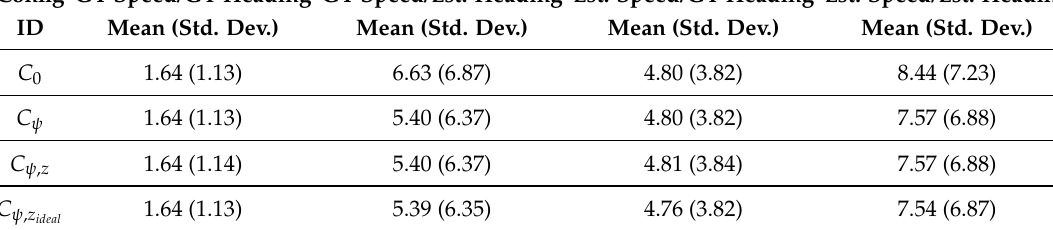
Table 11. Test Set: L 2 Position Errors (cm) for Varying Algorithm